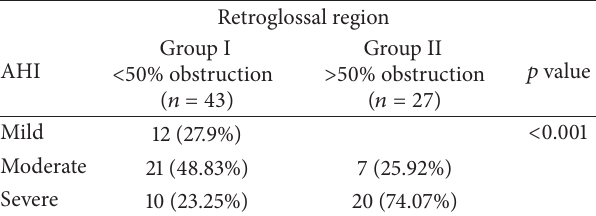
Table 6: AHI with retroglossal collapse.